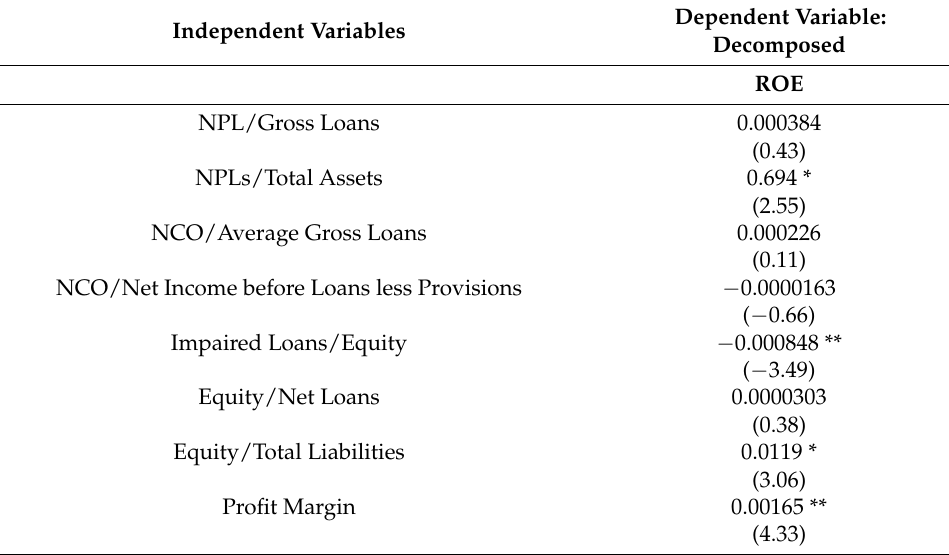
Table A13. Panel regression (with fixed effects for banks and time and robust standard errors) with decomposed ROE (measured as addressed by ECB (2010)) as the dependent variable and ratios deScheme 142. Italian banks and the timespan is from 2011 to